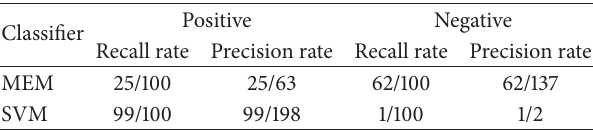
Table 1: Classification results in terms of the recall and precision rates for the classifier based on affective features estimated from LBP.